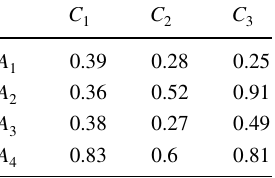
values of the alternatives with respect to optimum